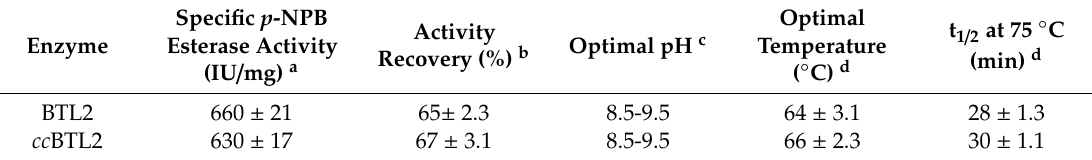
Table 1. Properties of BTL2 and cc BTL2 CNBr-Sepharose ® derivatives with 5 IU and 0.013 mg of protein /